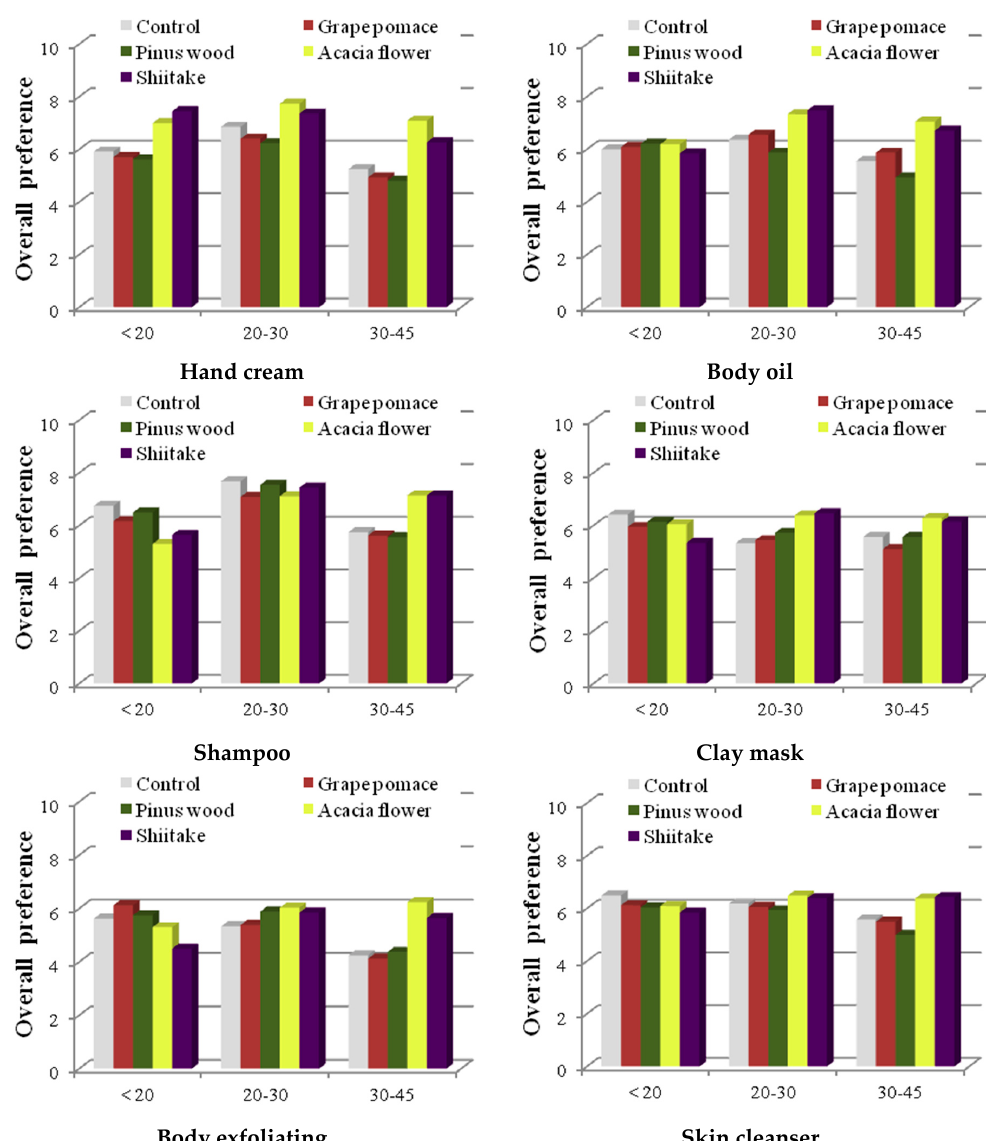
Figure 3. Overall appreciation for tested personal-care products according to the volunteers’ age-interval.